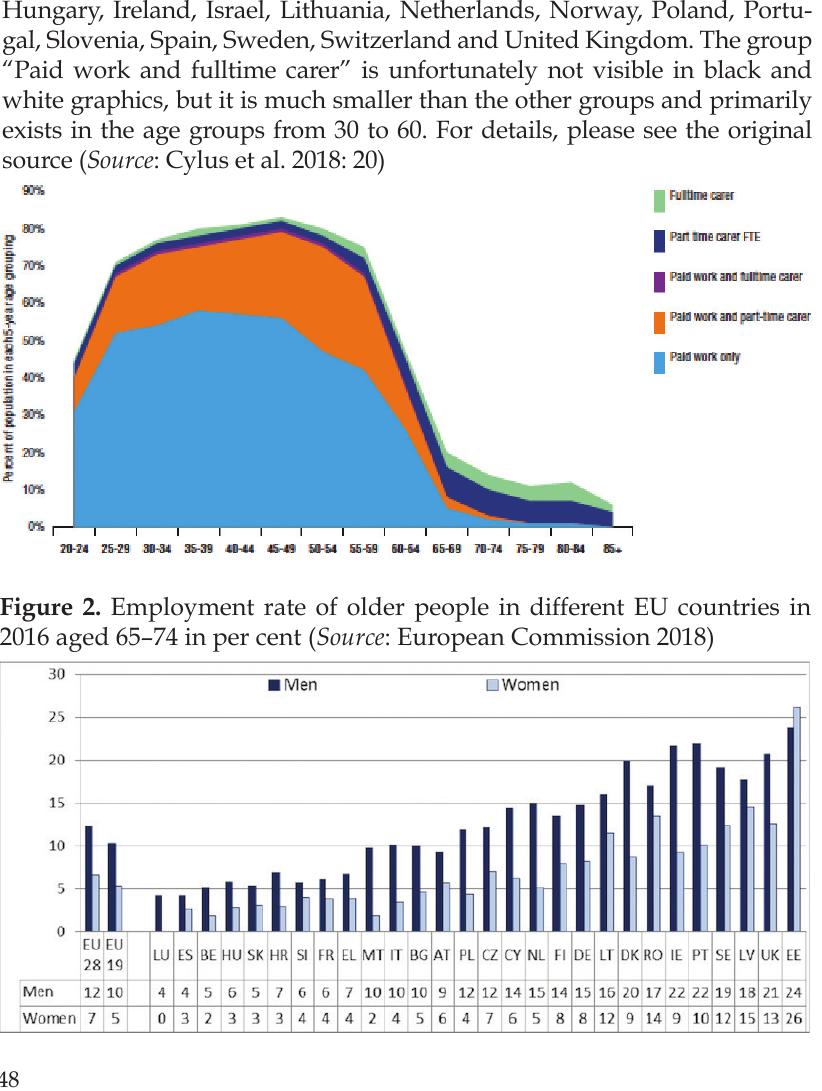
Figure 1. Age structure of the workforce, including formal careers, adjusted for full-time equivalence. Data from the European Social Survey including